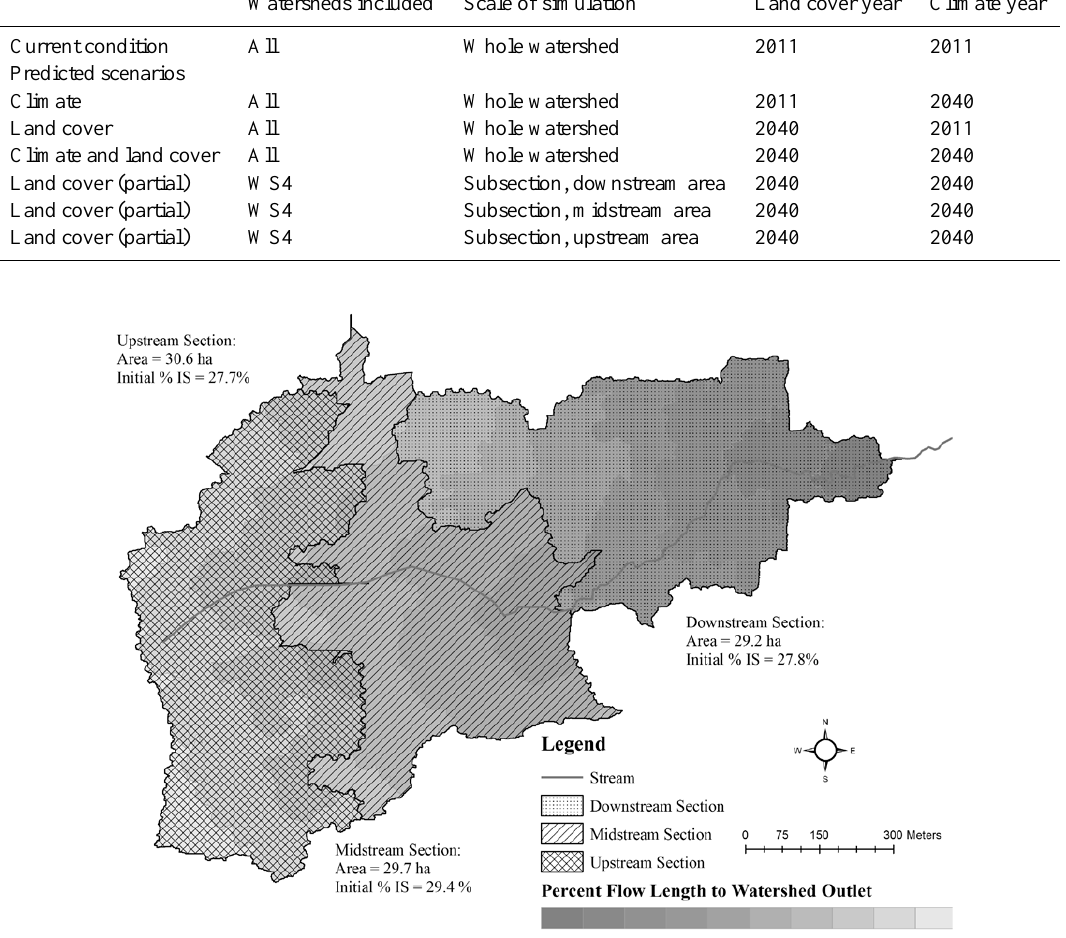
Fig. 2. Boundaries of the three sections for the different distributions of impervious land cover scenario for WS4. The three sections have similar area and percent impervious surface in 2011 (initial % IS). The downstream section includes 0 to 40% of flow length to the outlet, the midstream section includes 40 to 70%, and the upstream section includes 70 to 100% of flow length to the outlet.